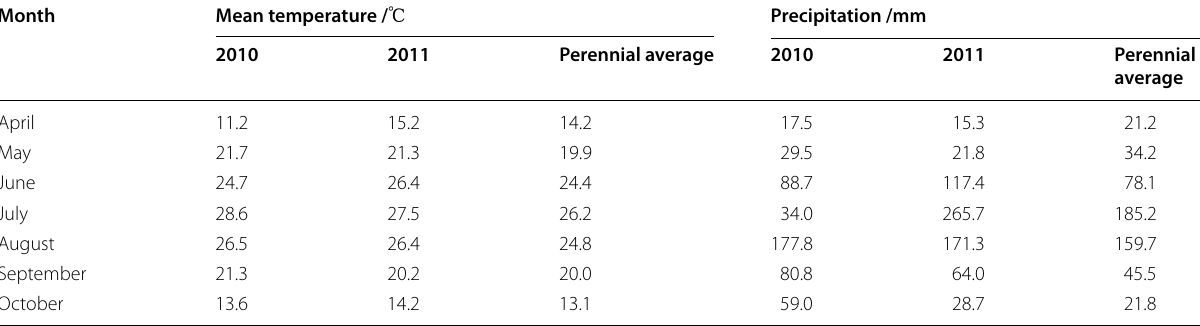
The data were provided by Meteorological Bureau of Haidian District, Beijing